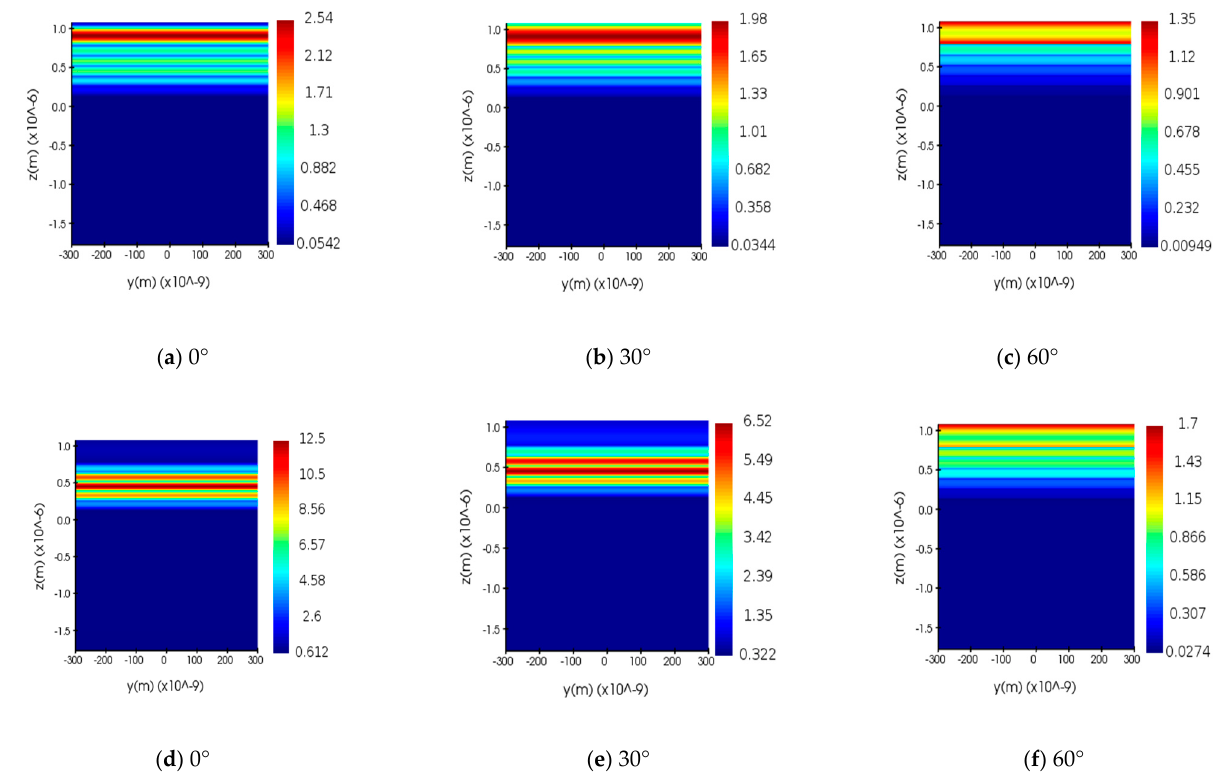
Figure 7. The squared of electric field propagates inside the ENZ multilayered metamaterial for ENZ wavelength at different incidence angles. ( a – c ) Without the gain medium. ( d – f ) With the gain medium.